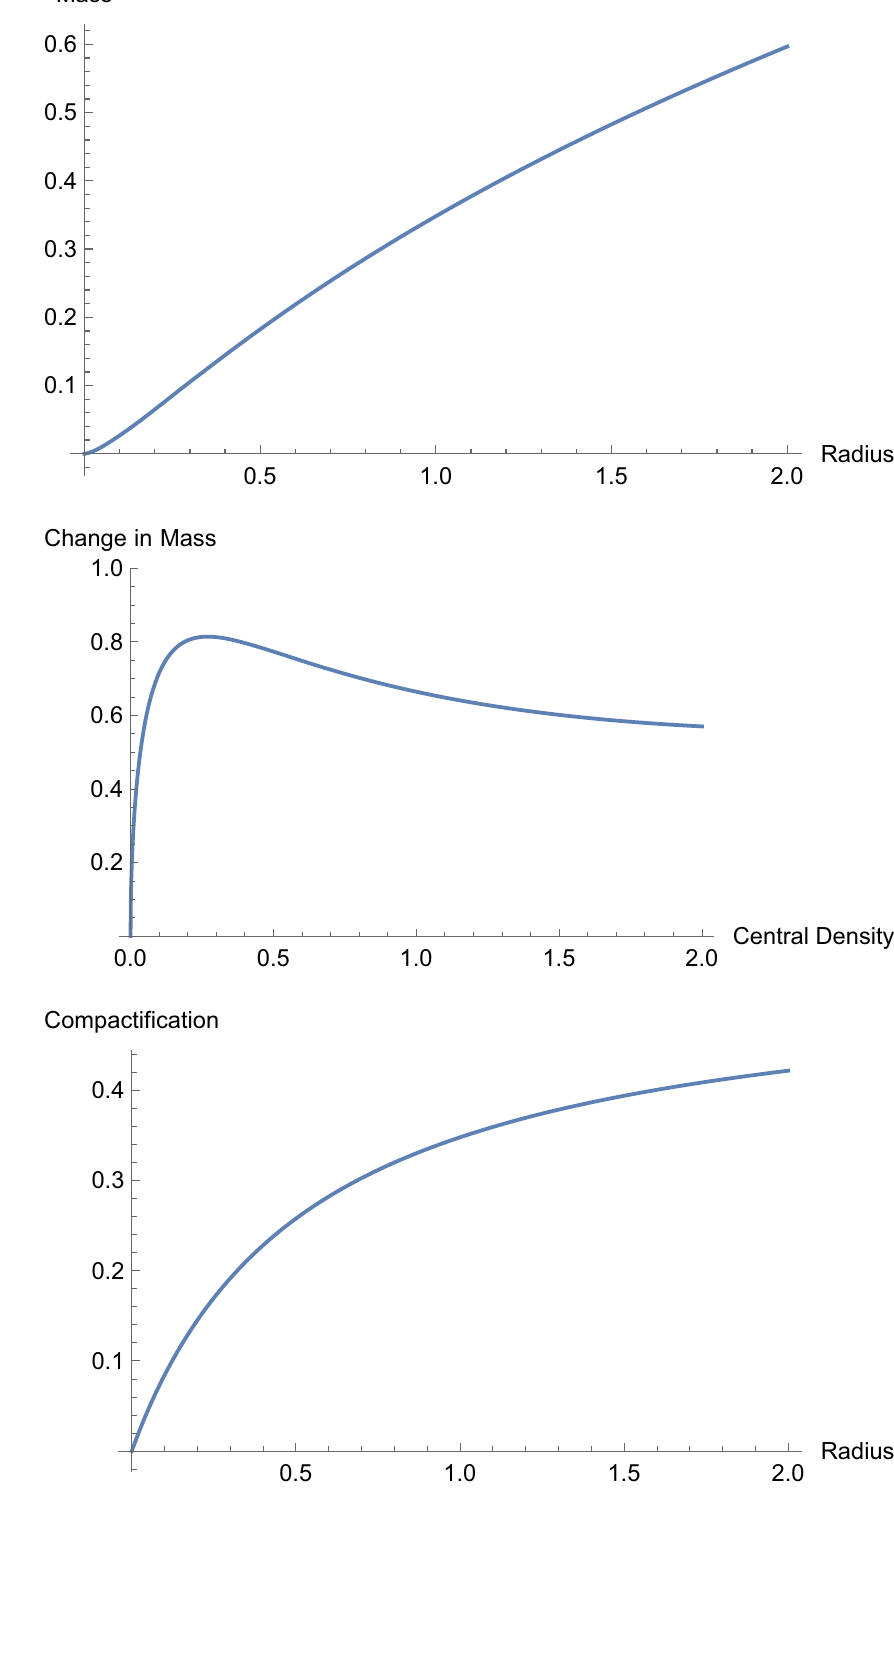
Fig. 16 Mass profile versus the radial variable x